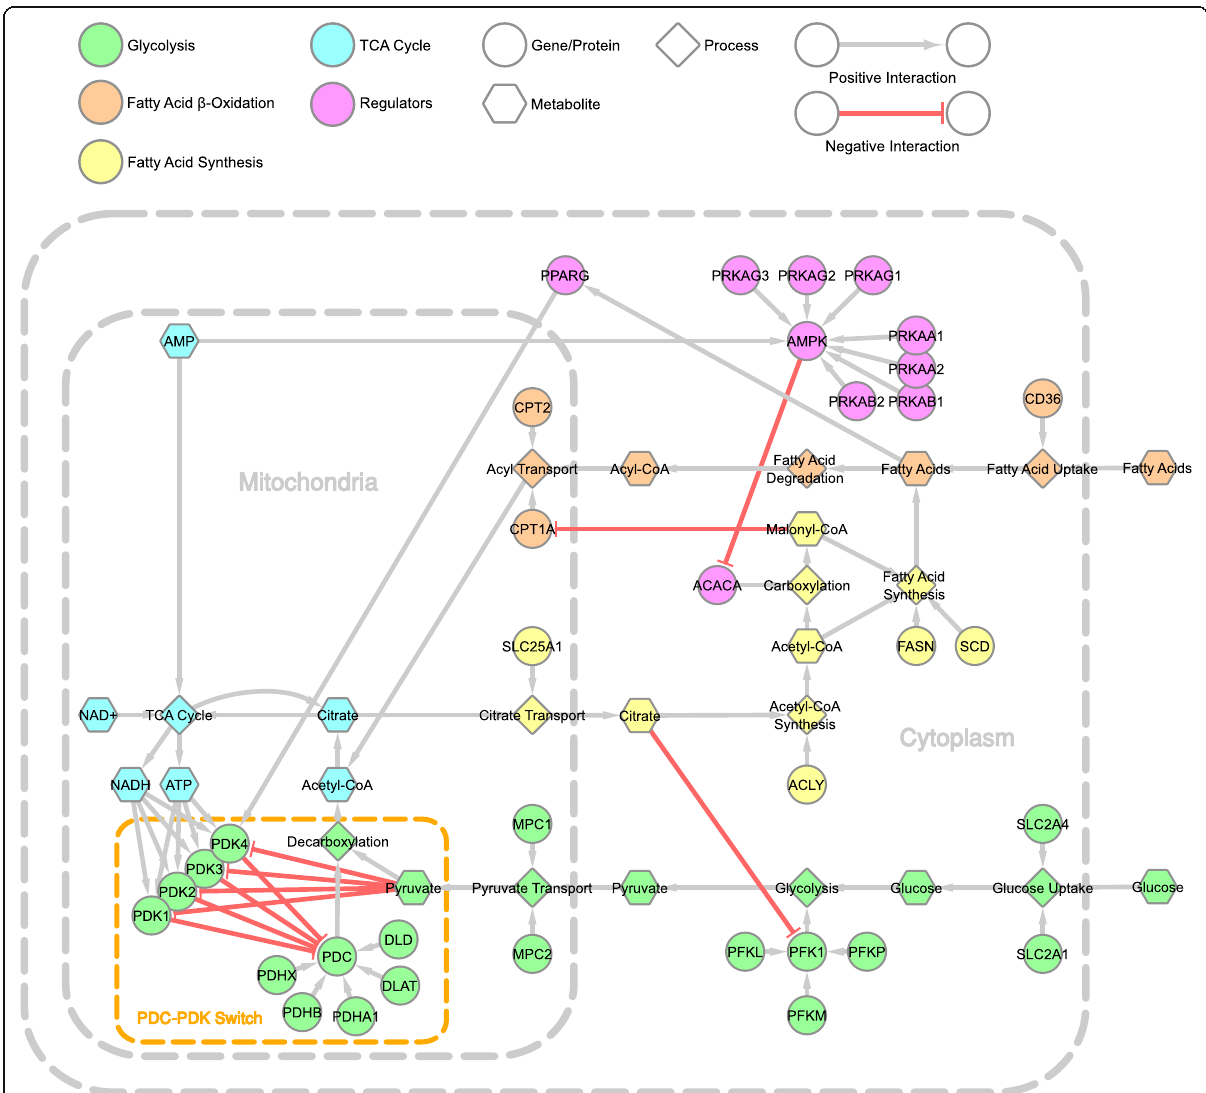
Fig. 2 Abstracted cellular network of metabolic flexibility in the adipose tissue. The network consists of different pathways and processes, which are grouped together into five major, colour-coded categories: (i) green for glycolysis, (ii) orange for fatty acid β -oxidation, (iii) yellow for fatty acid synthesis, (iv) cyan for TCA cycle and (v) magenta for regulators of metabolic